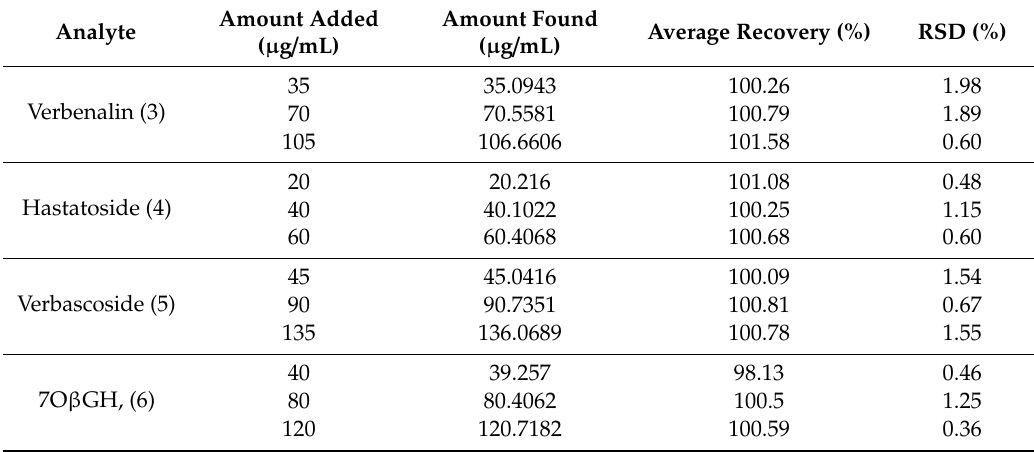
Table 1. Average recovery of the marker compounds ((3)–(6)) from V. carolina .